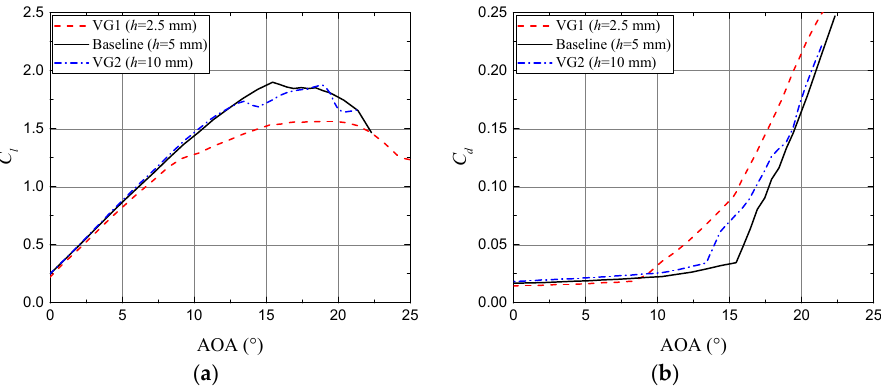
Figure 14. Experimental lift and drag coefficients of the stationary airfoil with different VGs in vane height: ( a ) C l ; ( b ) C d .